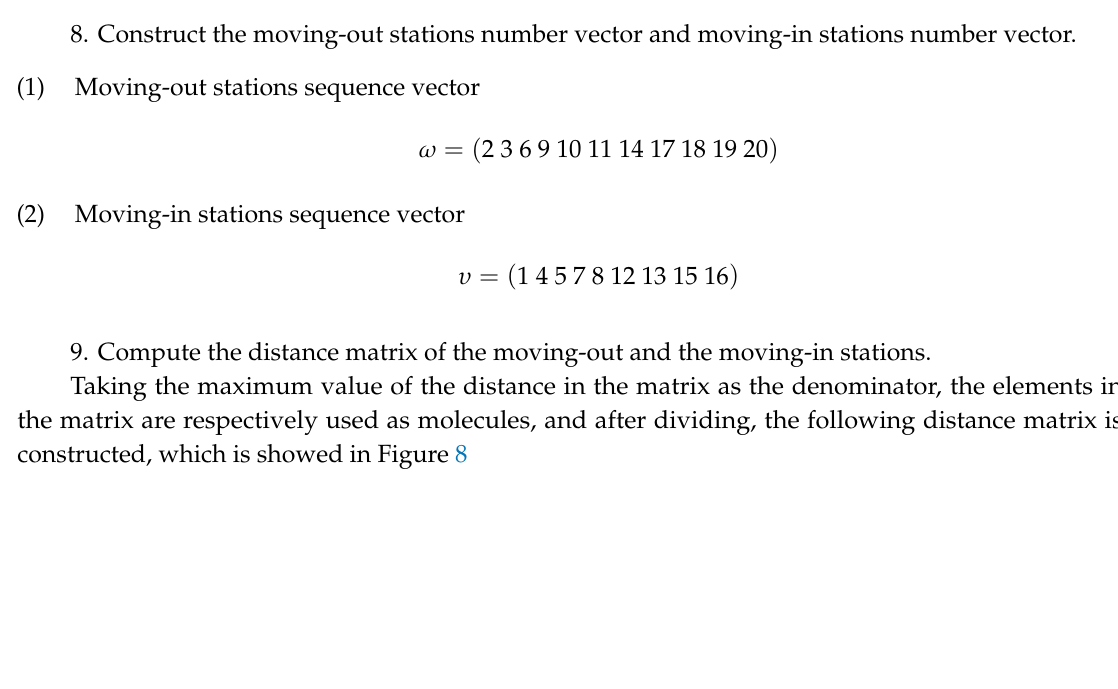
Figure 7. Statistical diagram of di ff erence between the steady-state fleet size vector and the actual fleet size